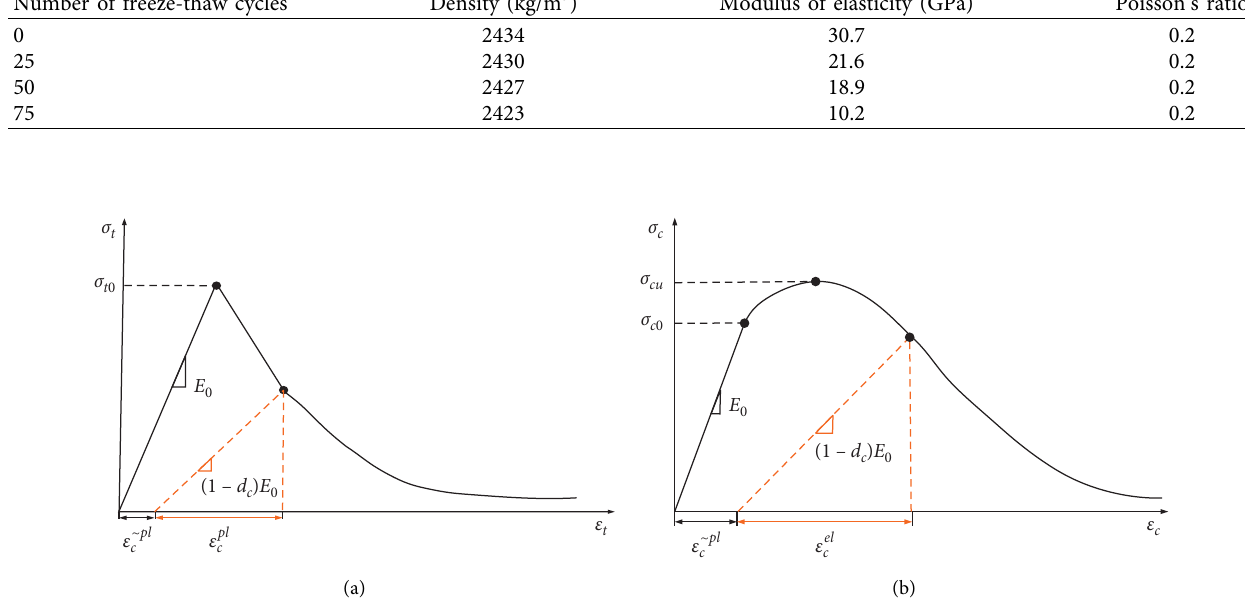
Table 3: Parameters (density, modulus of elasticity, and Poisson’s ratio) of concrete in the CDP model. Number of freeze-thaw cycles Density (kg/m 3 )